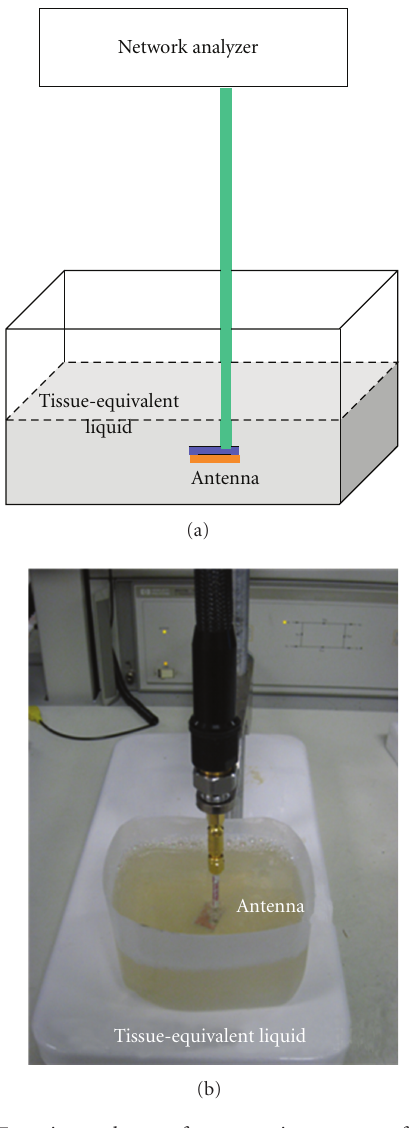
Figure 9: Experimental setup for measuring resonant frequencies of implantable antenna.